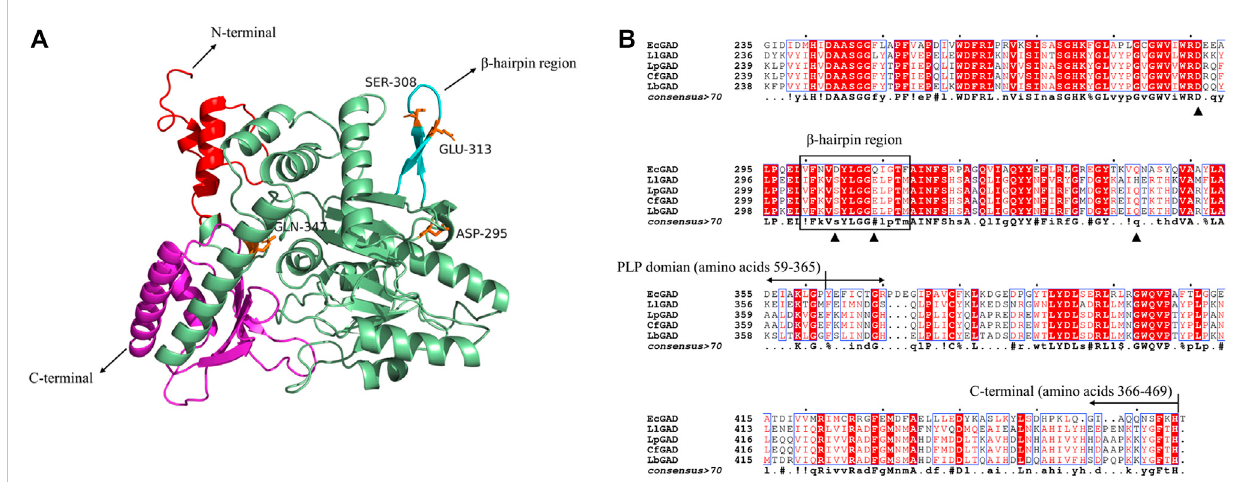
FIGURE 2 3D structural modeling and amino acid sequence analysis of LpGAD. (A) LpGAD structure predicted using the SWISS-MODEL server, using the GAD of Lactobacillusbrevis (PDBID5GP4)asatemplate.Red:aminoacids1 – 58attheN-terminal;palegreen:PLPdomain;cyan: β -hairpinregion(aminoacids 304 – 317); magenta: amino acids 366 – 469 at theC-terminal; orange: mutated amino acid site. (B) LpGAD amino acid sequence analysis. EcGAD, LlGAD, LpGAD, CfGAD, and LbGAD represent the GAD of Escherichia coli , Lactococcus lactis , Lactobacillus plantarum LC84, Companilactobacillus futsaii and Lactobacillus brevis CGMCC 1306, respectively; triangles represent mutated amino acid sites; black boxes represent β -hairpin region (amino acids 304 –